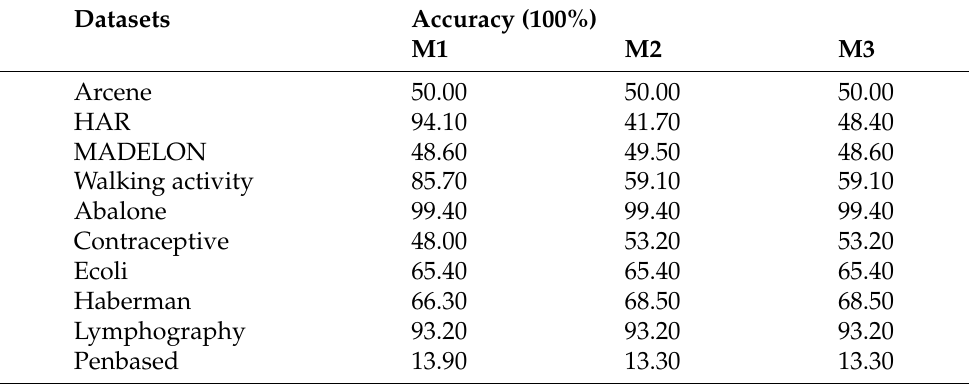
Table 4. Classification results on all datasets using SVM classifier.